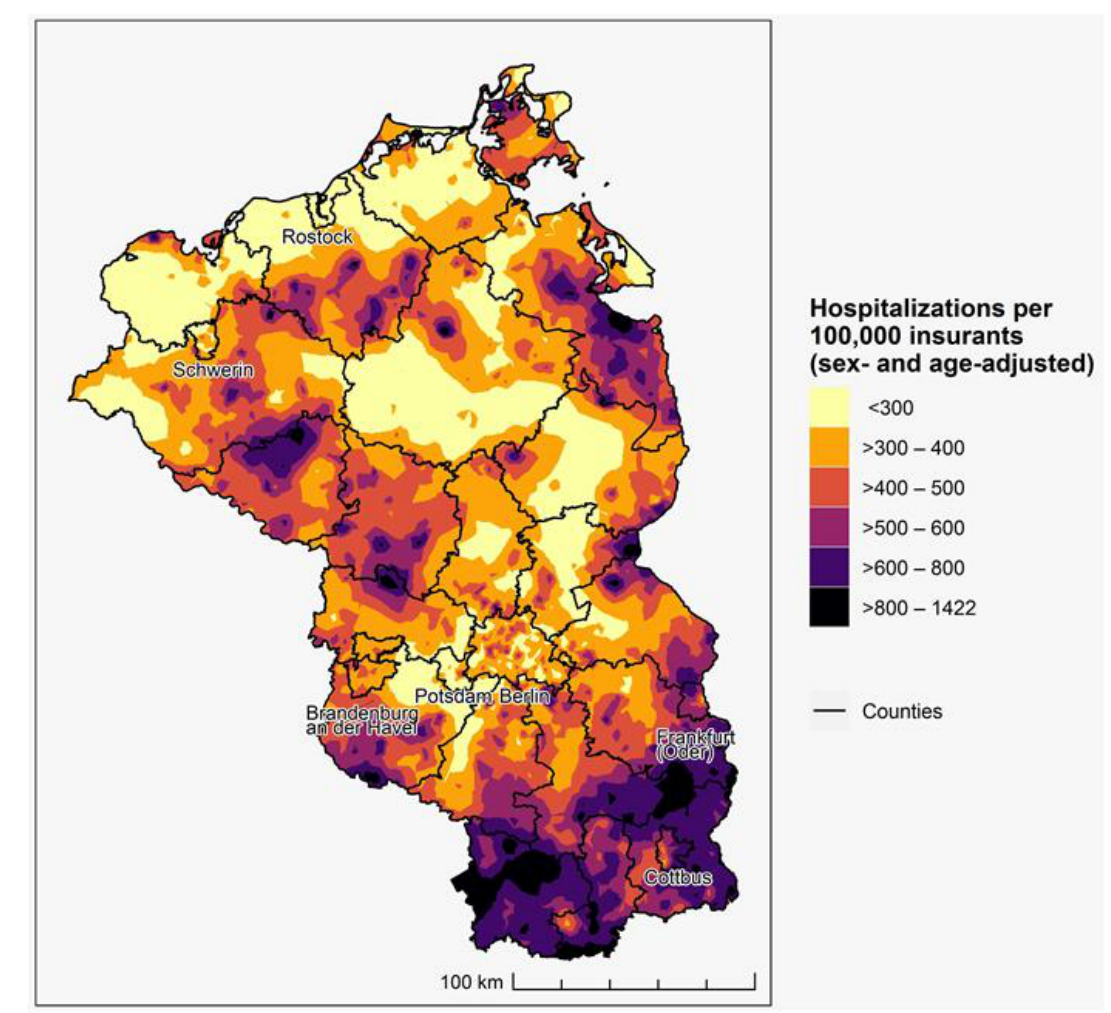
Figure 1. Accumulated one-year incidence of COVID-19 hospitalizations (2021). Table 1. Regression coefficients for COVID-19